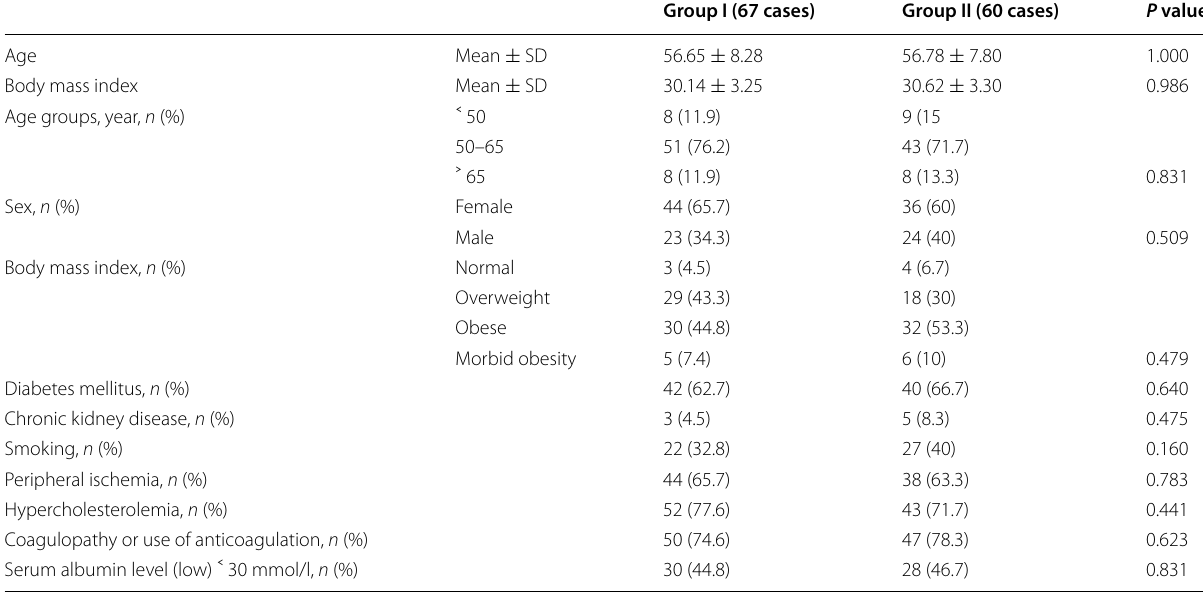
SD standard deviation, Group I used NPWT, Group II conventional wound care